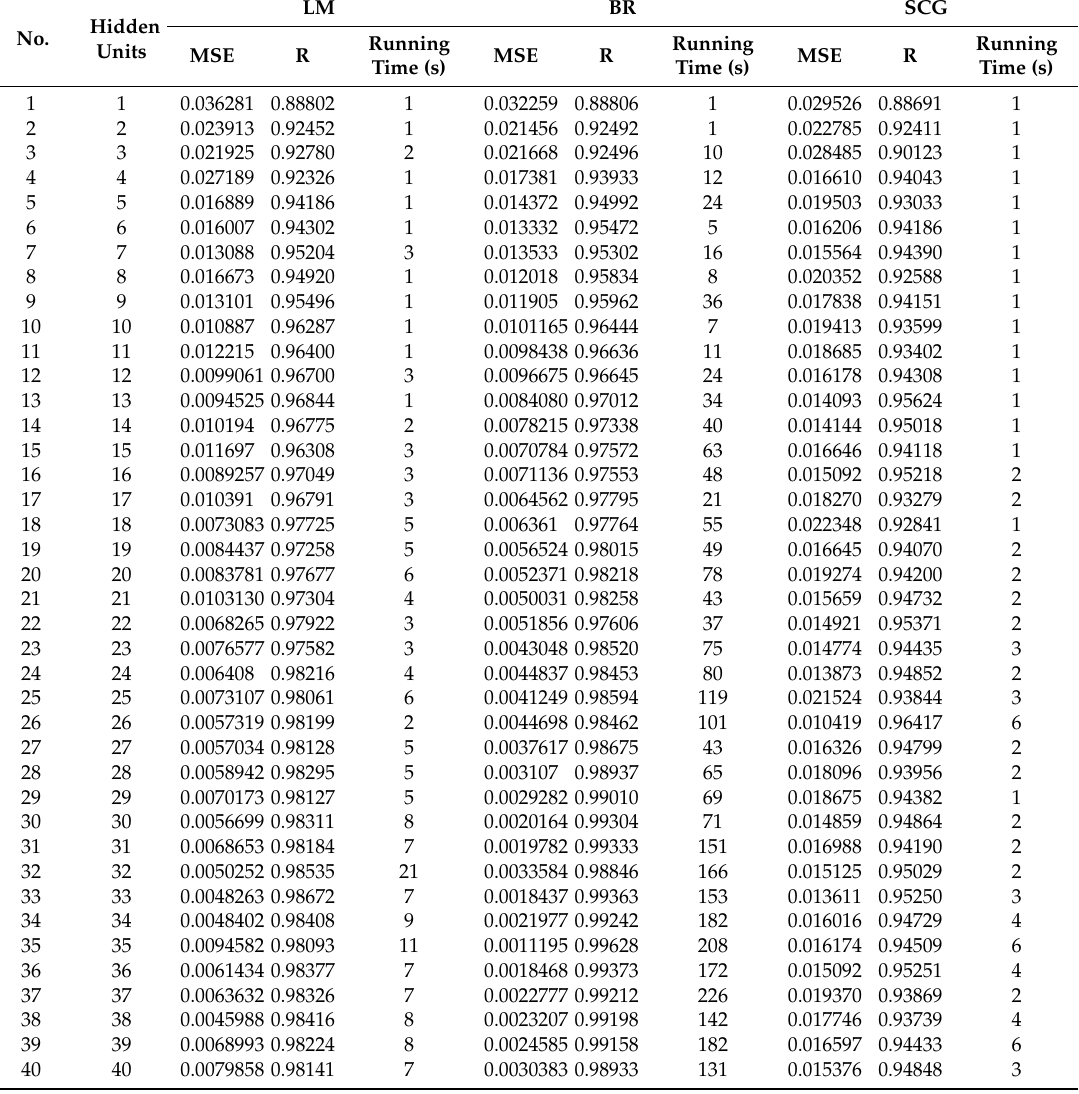
Table A2. The experimental results when developing the FITNET ANN forecasting solutions for the produced and consumed